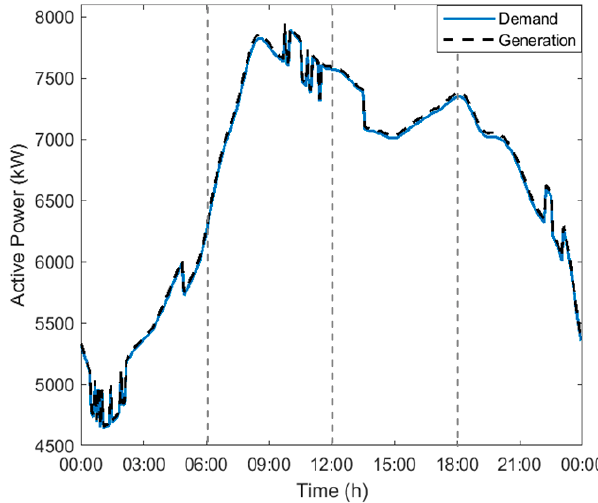
Figure 7. Demand vs. generation for 34-bus system.